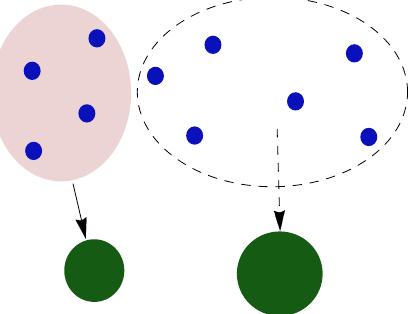
Figure 1. A representation of the condensation of a SVOC, shown by the blue dots, onto two non-volatile particles, shown by the green circles. The SVOC is divided into two groups: those that condense onto the left involatile particle (highlighted in pink) and those re- maining to equilibrate on the right particle (circled by the dashed black